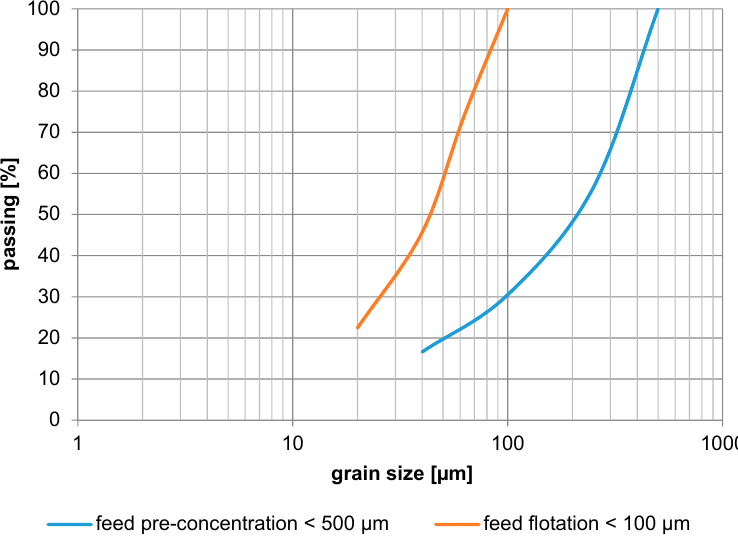
Figure 5. Grain size distribution (feed pre-concentration, feed flotation).